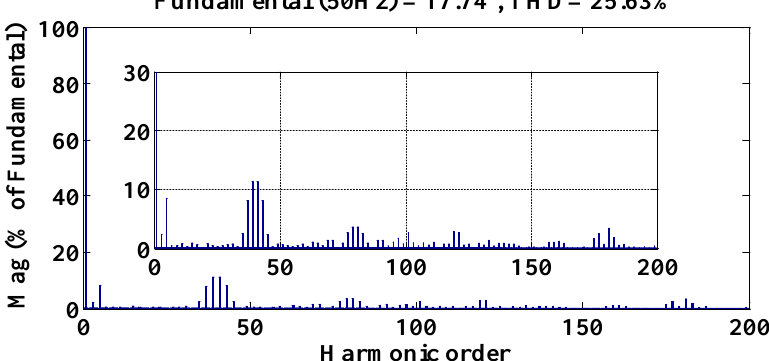
Figure 12. FFT plot for the output voltage of the COPWM strategy. Energies 2018 , 11